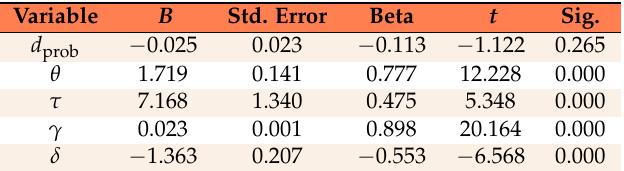
Table 4. OLS regression coefficients with N g as the independent variable.